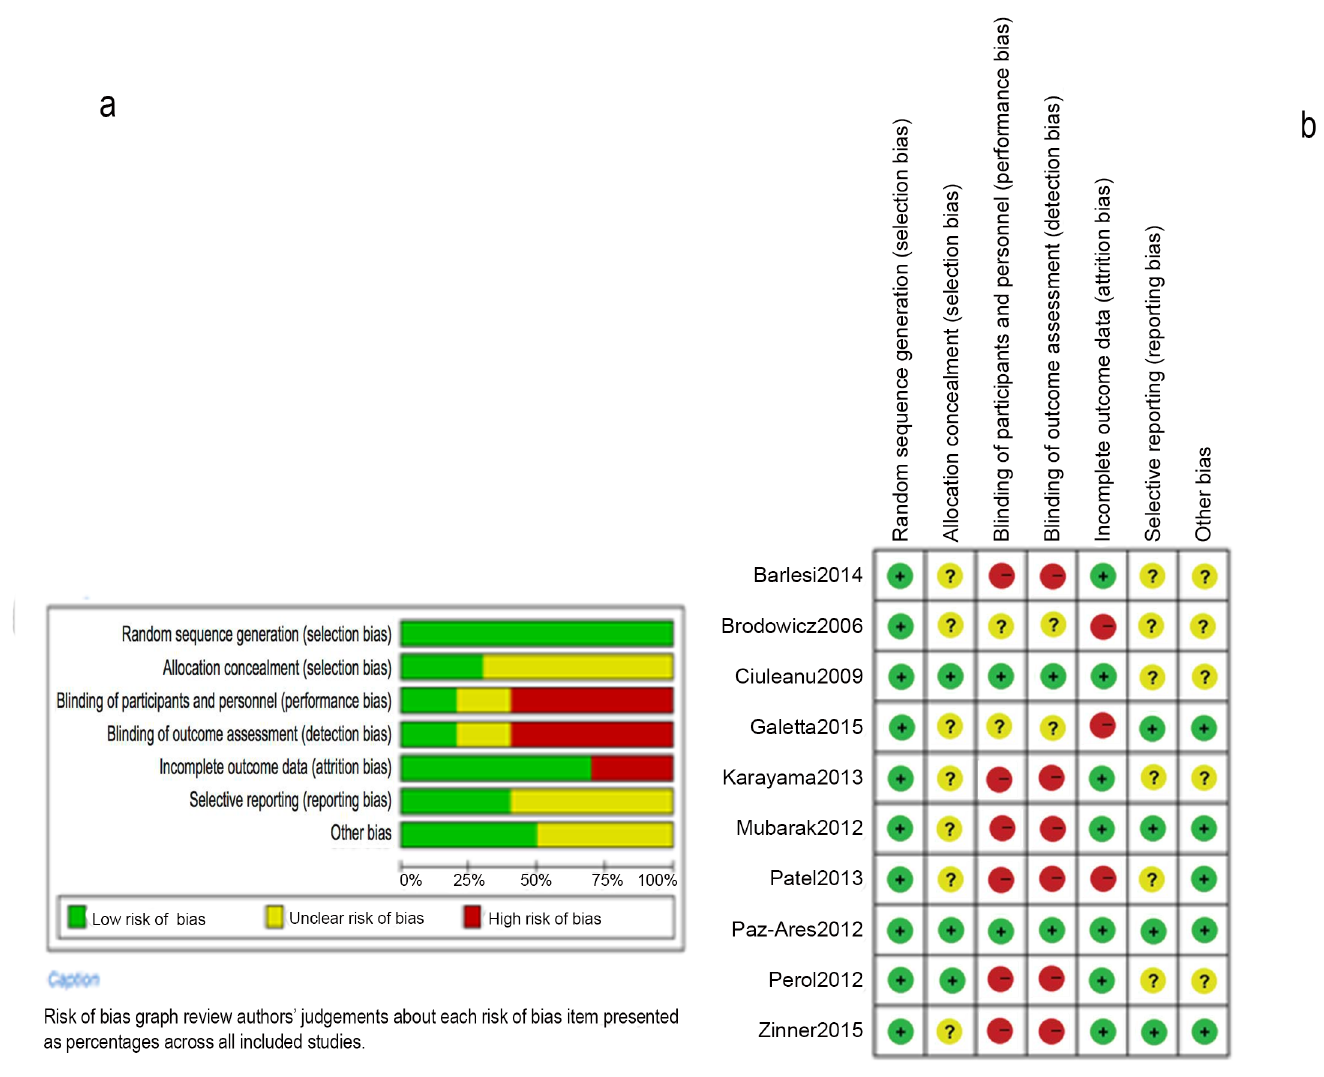
Fig 2. Risk of bias graph (a) and risk of bias summary